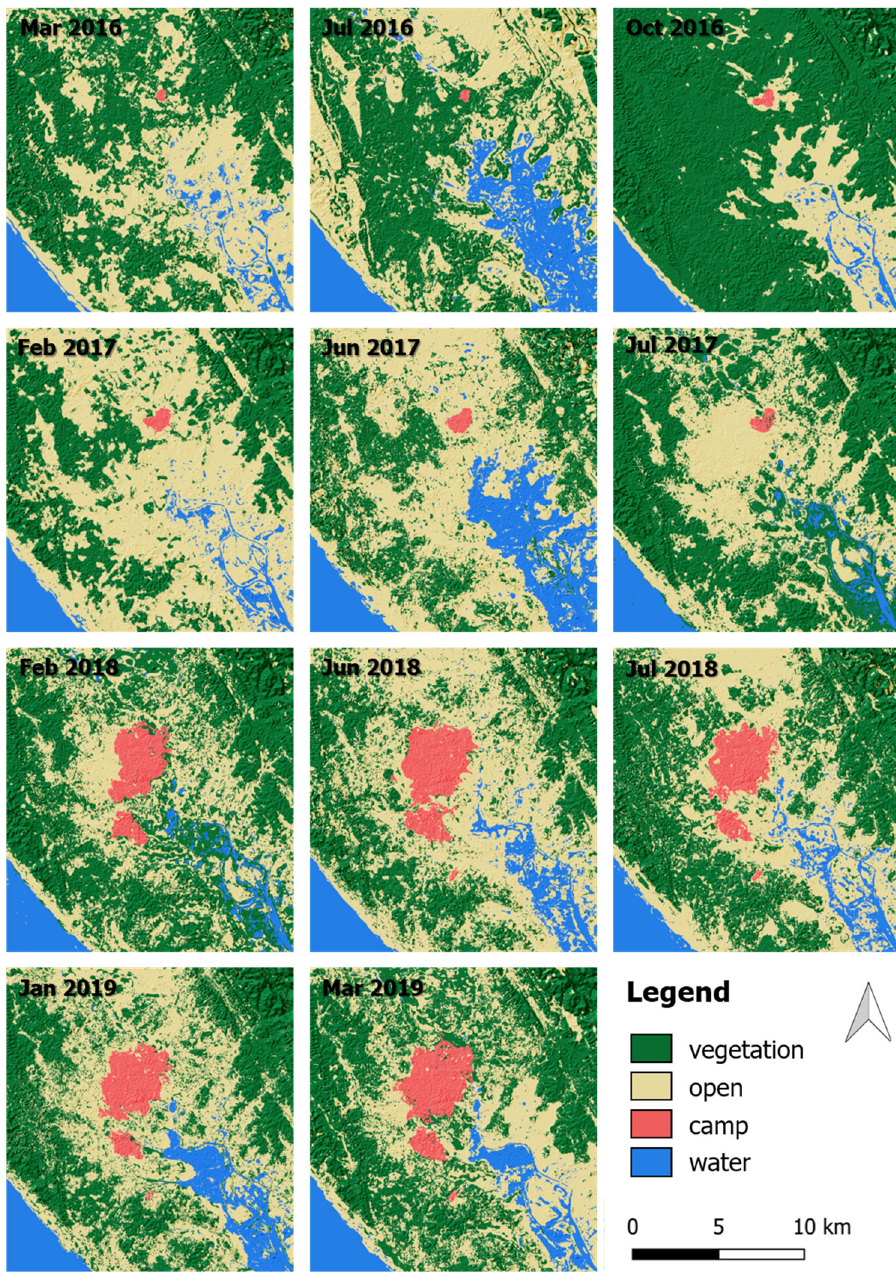
Figure 4. Land cover classification of the study area between March 2016 and March 2019.